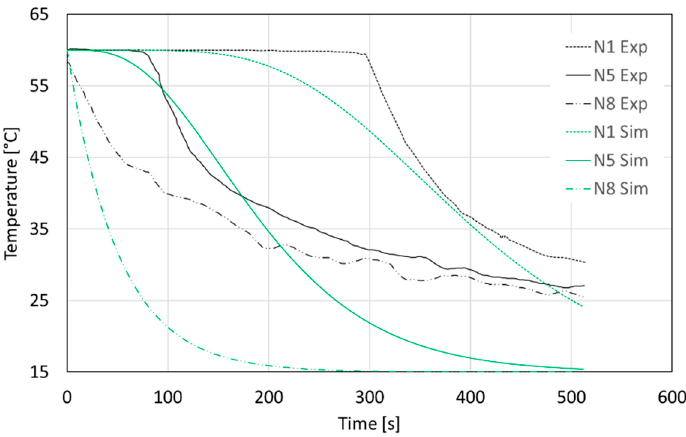
Figure 18. Temperature evolution during the discharge phase—experimental vs. simulated—10 dm 3 / min volume flow rate.